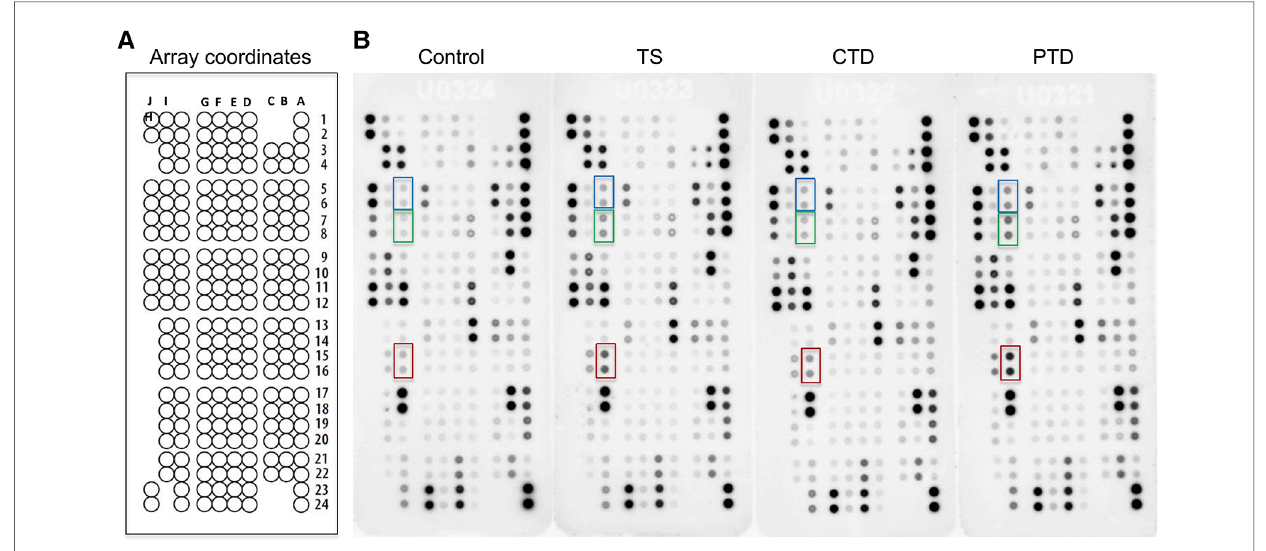
FIGURE 1 Cytokine array analysis of plasma from patients with tic disorders and healthy controls. ( A ) Schematic diagram of cytokine array coordinates representing 105 different capture antibodies printed in duplicate. ( B ) Array results for control subjects, and TS, CTD, and PTD patients. Dots representing CCL5, PDGF- AA, and PDGF-AB/BB are highlighted in red, blue and green,